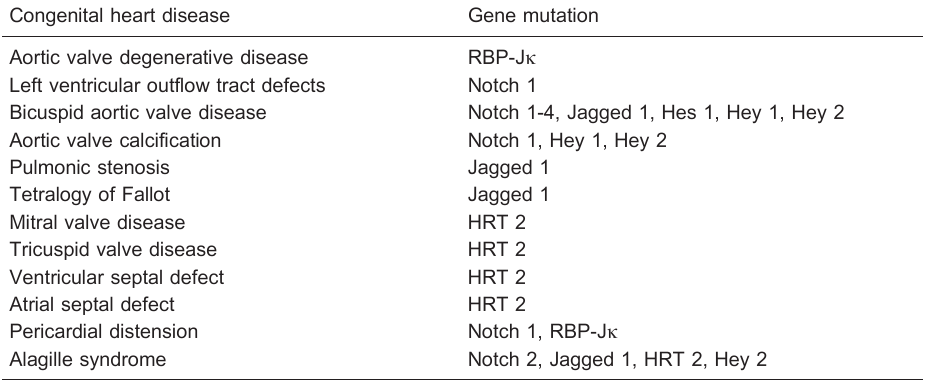
Table 1. Relationship between Notch signaling and congenital heart disease. Congenital heart